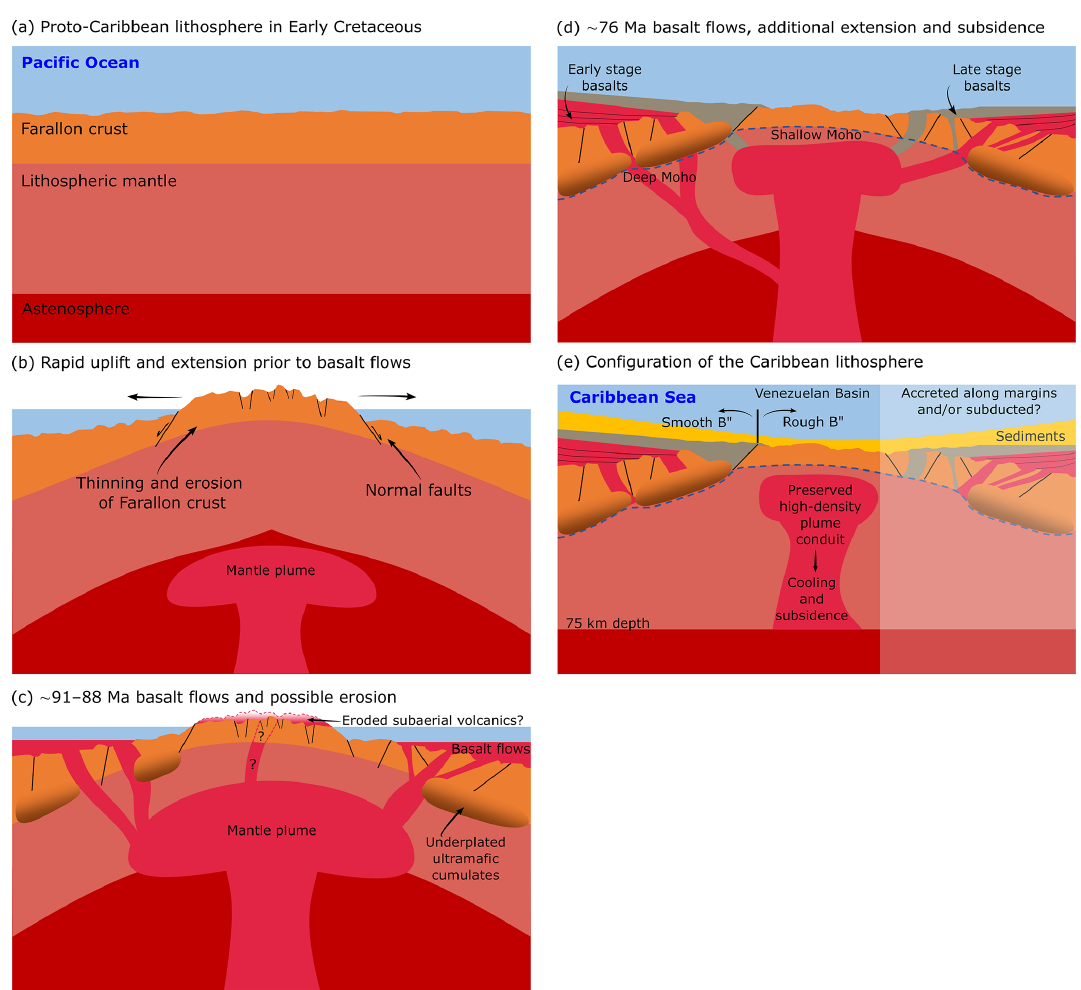
Figure 14. Cartoon illustrating the tectonic development of the Caribbean crust (Venezuelan Basin) due to the interaction of the Farallon plate with a mantle plume. (a) Proto-Caribbean lithosphere with a normal crustal thickness in the Early Cretaceous. (b) Rapid uplift and thinning of the lithosphere due to the inflow of hot, buoyant plume material. This stage should also have included the erosion of the uppermost crustal structures (e.g. Ernst, 2007, 2014) such as horsts and grabens associated with the stretching of the crust. Thus, only the main faults are preserved. (c) The early stage basalts are spilled over the modified Proto-Caribbean crust, probably including subaerial erosion of the ones spilled over the emerged portion of the crust. In this stage, the underplated ultramafic cumulates contributed to crustal thickening. Question marks indicate that the existence of magma conduits beneath the proposed centre(s) of uplift remains unclear. (d) The late basalts covered the crust, which experienced additional extension and subsidence. In this stage, a differential Moho depth becomes more evident. (e) In the present-day configuration of the Caribbean plate, the smooth basement (B (cid:48)(cid:48) horizon) is mainly preserved in the areas outside the uplift centre. The deepest Venezuelan and Colombian basins correlate with the most extended crustal domains, where the doming was more pronounced. Due to the north–north-eastward migration of the Proto-Caribbean plate, fragments of the C-LIP were subducted or accreted to the continental margins of the South American